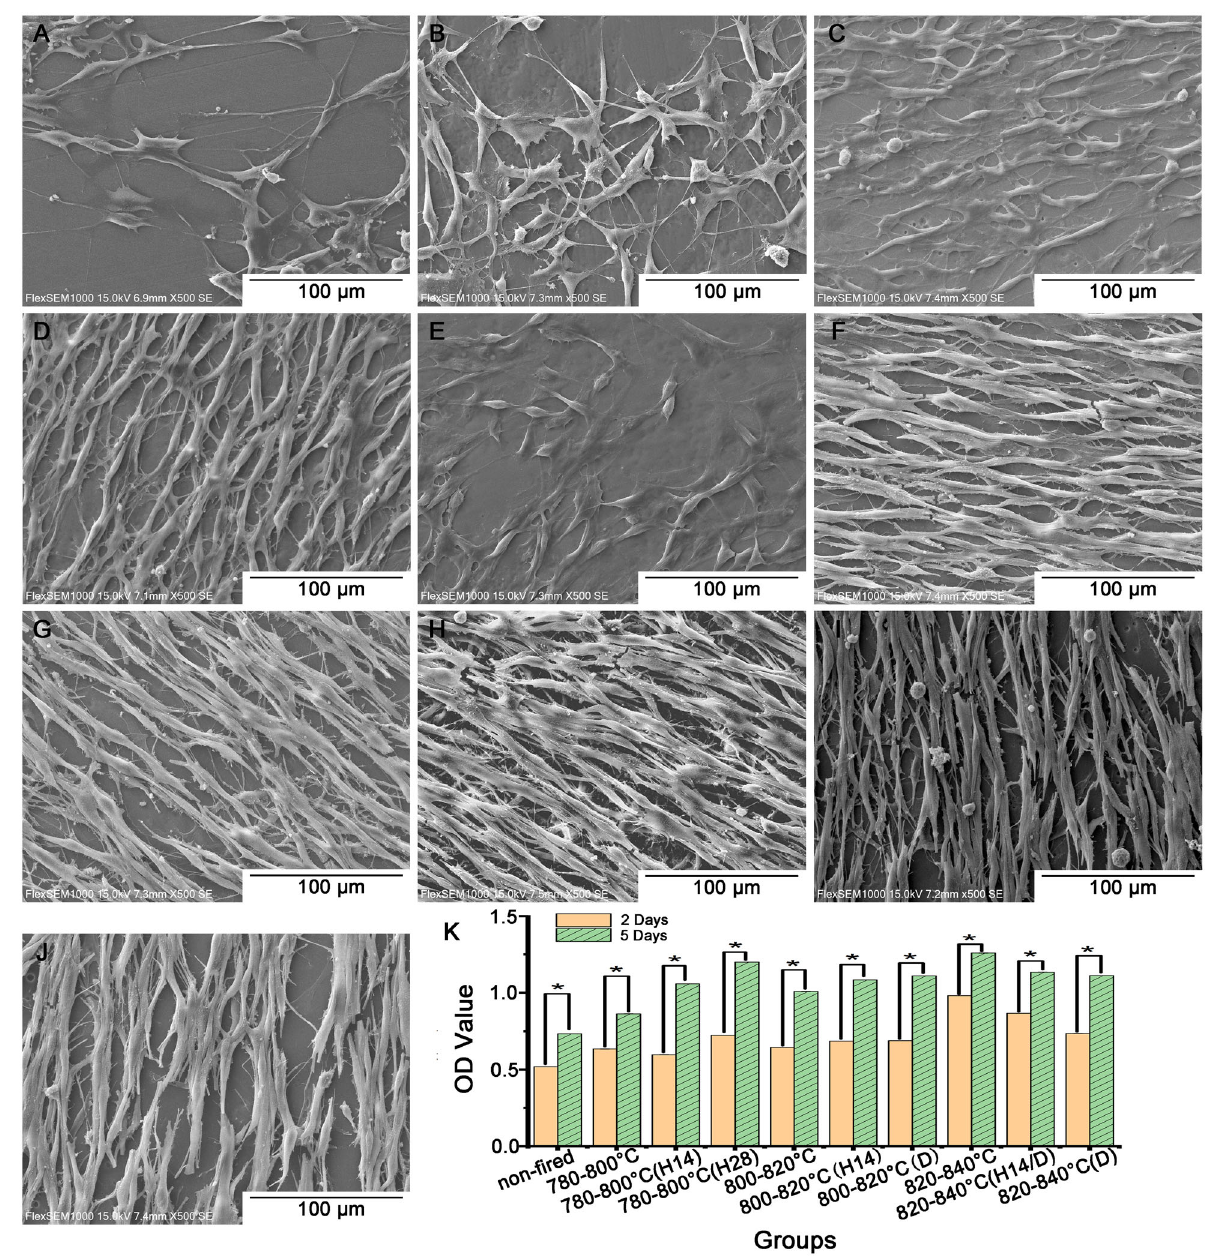
Fig. 7 Representative SEM micrographs of MC3T3-E1 cells after 5 days culture on LDGC discs ( A ) non- fi red; ( B ) 780 – 800 °C; ( C ) 780 – 800 °C (H14); ( D ) 780 – 800 °C (H28); ( E ) 800 – 820 °C; ( F ) 800 – 820 °C (H14); ( G ) 800 – 820 °C (D); ( H ) 820 – 840 °C;